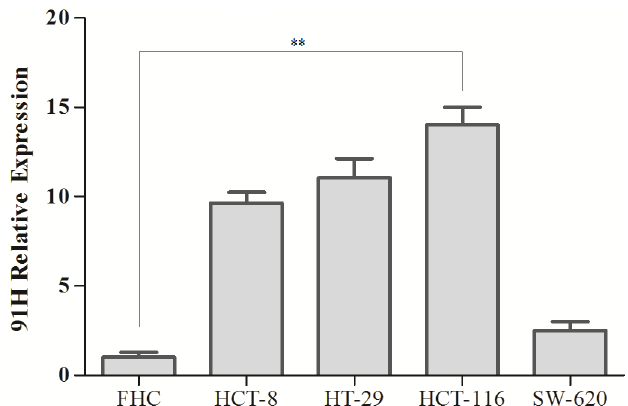
Figure 7. 91H relative expression was quantified in four CRC cell lines and a normal human intestinal epithelial cell line by qRT-PCR (mean ± SEM; ** P , 0.01).